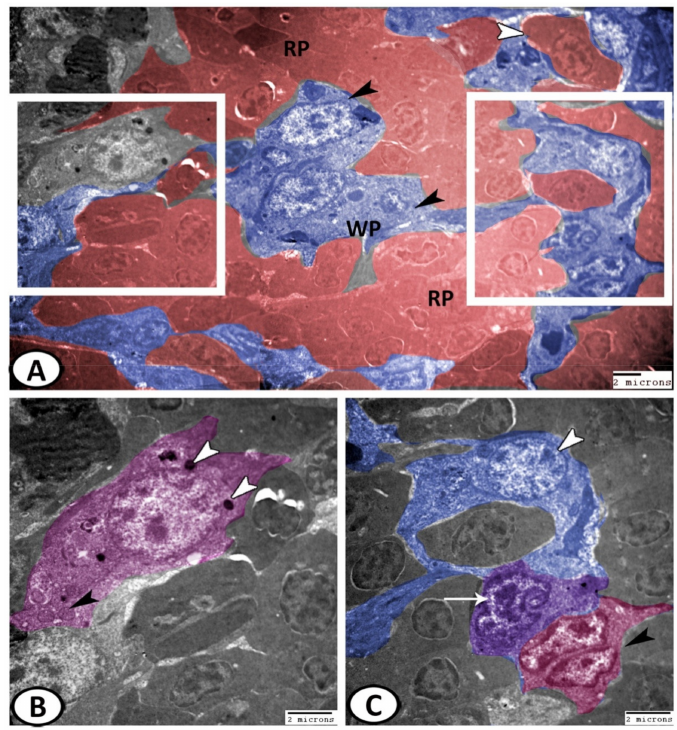
Figure 8. Digital colored TEM of the cells in the spleen. ( A ) The splenic parenchyma was comprised mainly of the red pulp (red, RP) intermingled with clusters of white pulp cells (blue, WP). Note, erythrocytes (white arrowheads) and macrophages (black arrowheads) with phagocytosed materials. ( B ) Higher magnification of the left boxed area in ( A ) illustrating neuron (pink) that contained a large euchromatic nucleus, mitochondria (black arrowhead), and lysosomes (white arrowheads). ( C ) Higher magnification of the right boxed area in ( A ) showing that dendritic cells (violet, arrow) with an indented heterochromatic nucleus and stem cells (pink, black arrowhead) with a dividing nucleus were observed in the splenic parenchyma. Note the branched epithelial reticular cells (blue, white